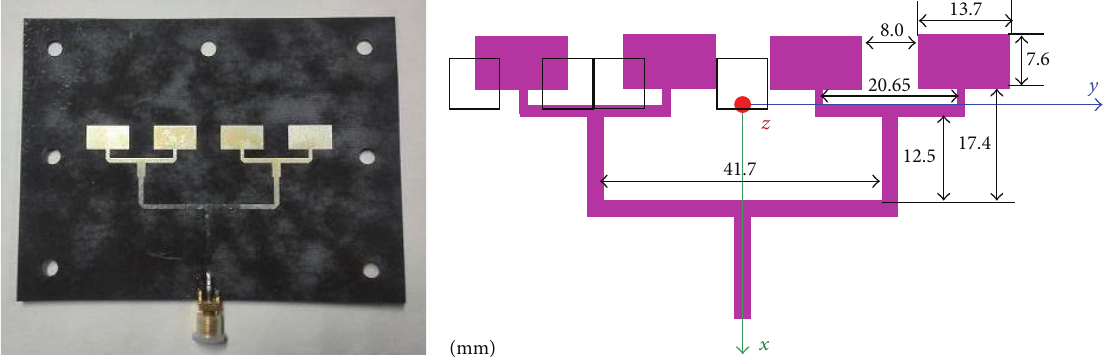
Figure 3: Microstrip antenna array used in the simulation (mm).